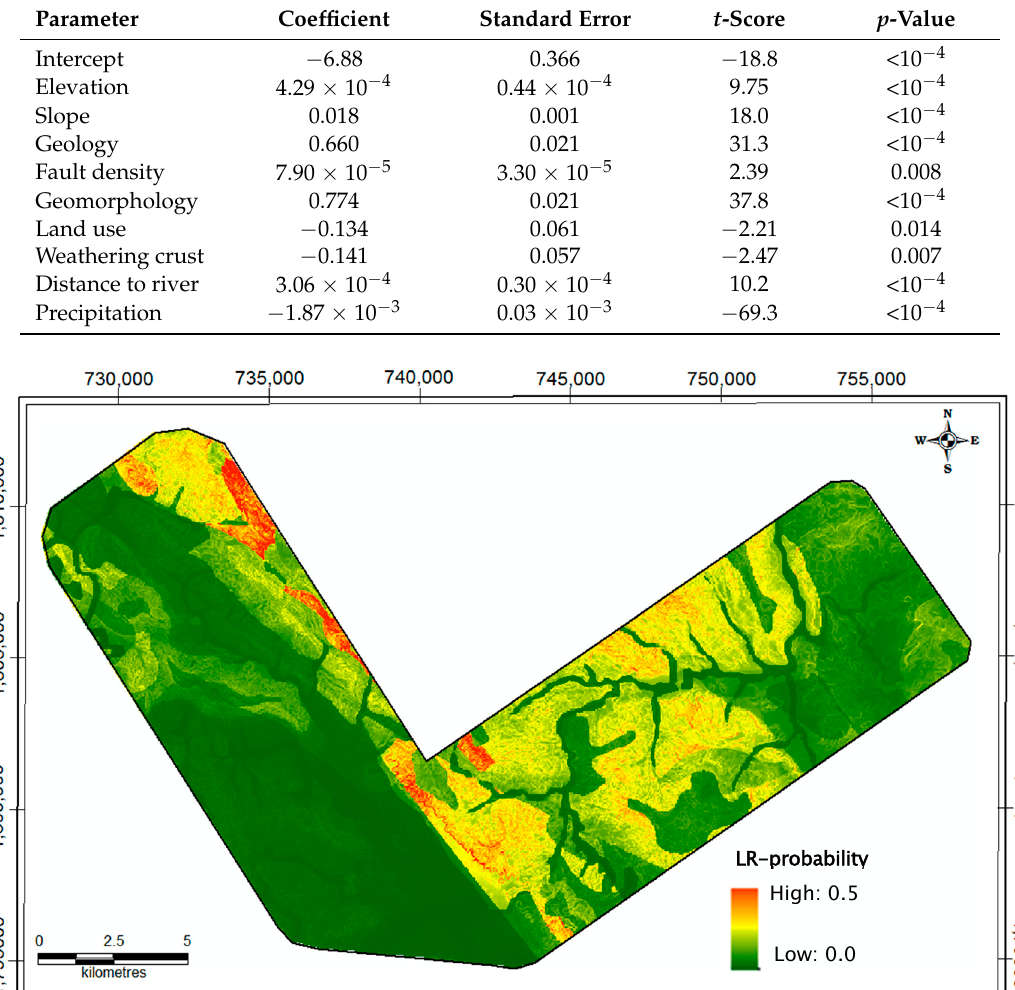
Figure 4. Landslide susceptibility map based on the certainty factor model. ROC curves of all models are presented in Figure 5 together with their AUC values, from which it can be concluded that the CF model perform best, although differences with the other models are